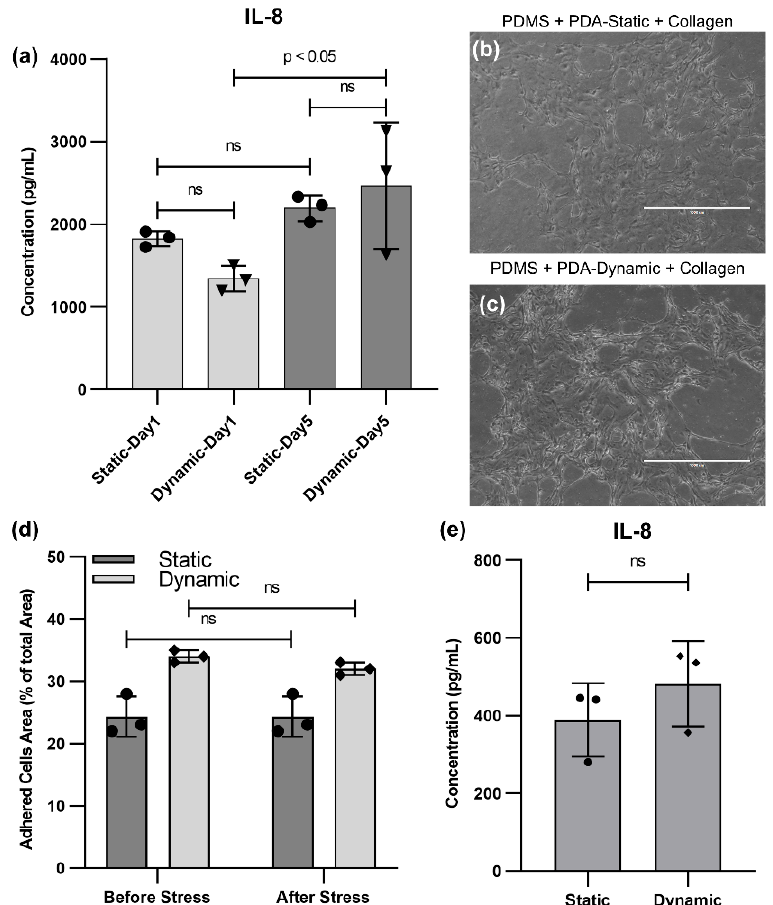
Figure 3. HBEC conditions before and after flow stress test: ( a ) IL-8 cytokine production by HBECs before flow stress at Day 1 and Day 5 for PDMS-treated surfaces with collagen after dynamic or static PDA coating, ( b ) a bright field image of HBECs on a PDMS-treated surface with collagen using static PDA coating after the flow stress test, ( c ) a bright field image of HBECs on a PDMS-treated surface with collagen using dynamic PDA coating after the flow stress test, ( d ) a comparison of the adhered cells area as a percentage of the total area before and after flow stress testing for both dynamic and static PDA coating, and ( e ) IL-8 cytokine production by HBECs after flow stress for PDMS-treated surfaces with collagen after the dynamic and static PDA